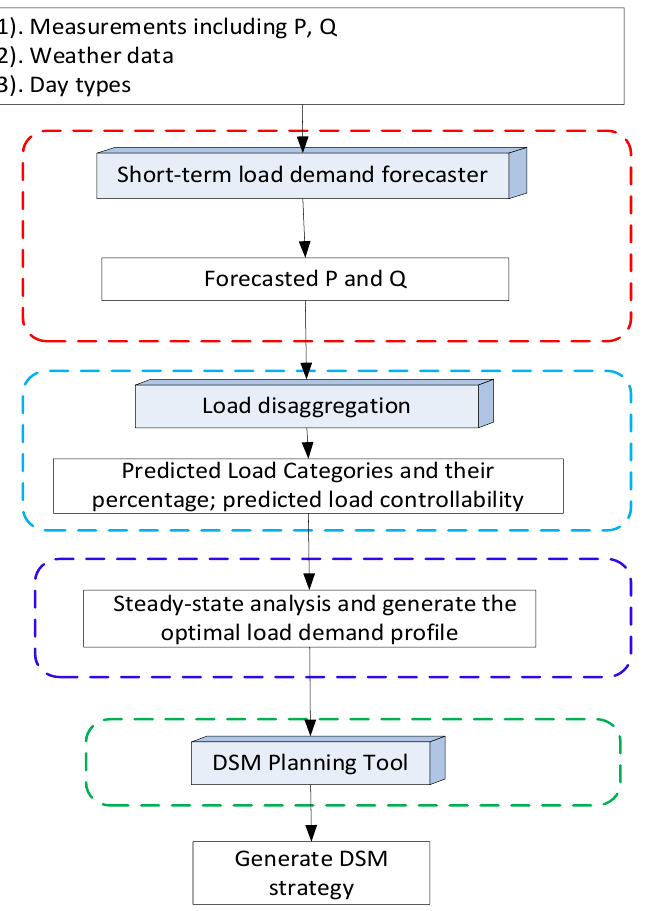
Figure 3. Illustration of load forecasting and DSM.